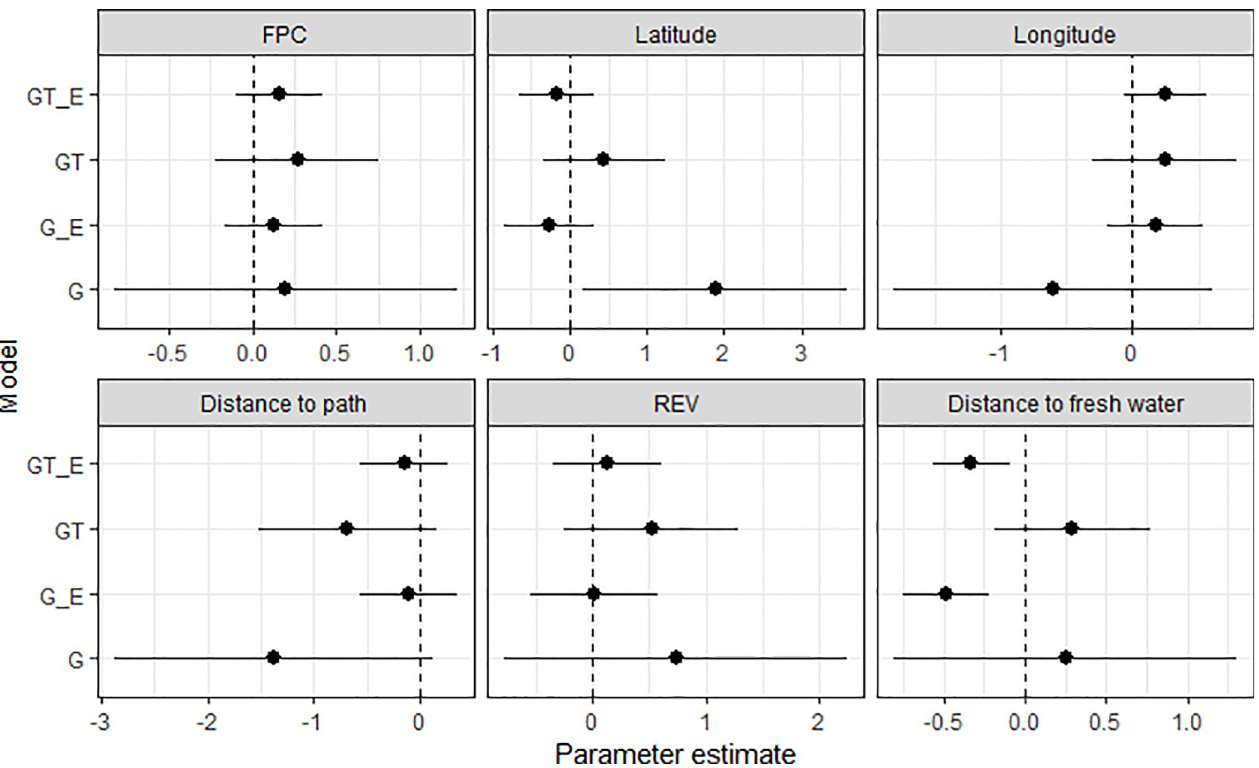
Fig 3. Parameter estimates and confidence intervals for model covariates. Shown as closed circles with 95% confidence intervals (horizontal bars) for each regression parameter in each model. G = ground survey only, G_E = combined ground-survey and expert-elicitation, GT = ground and thermal-imagery surveys, GT_E = combined ground and thermal-imagery surveys and